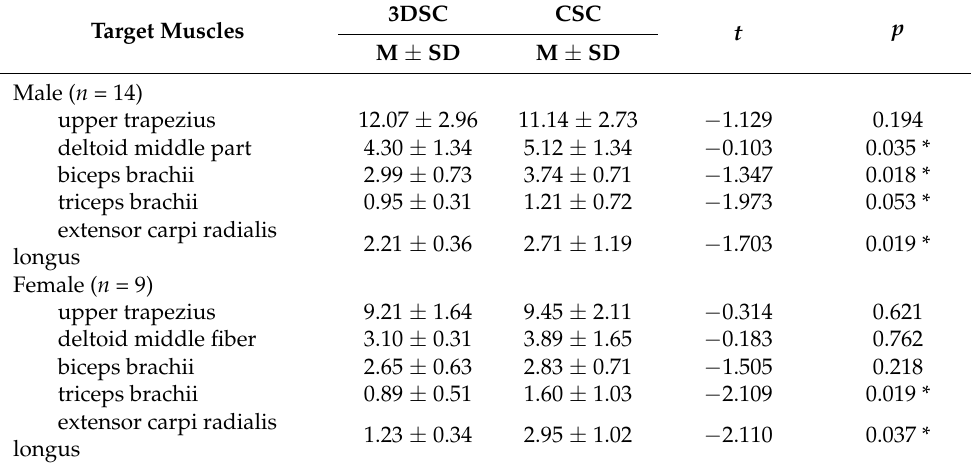
Table 2. Comparison of Muscle Activities (%MVIC) during sEMG measurement.